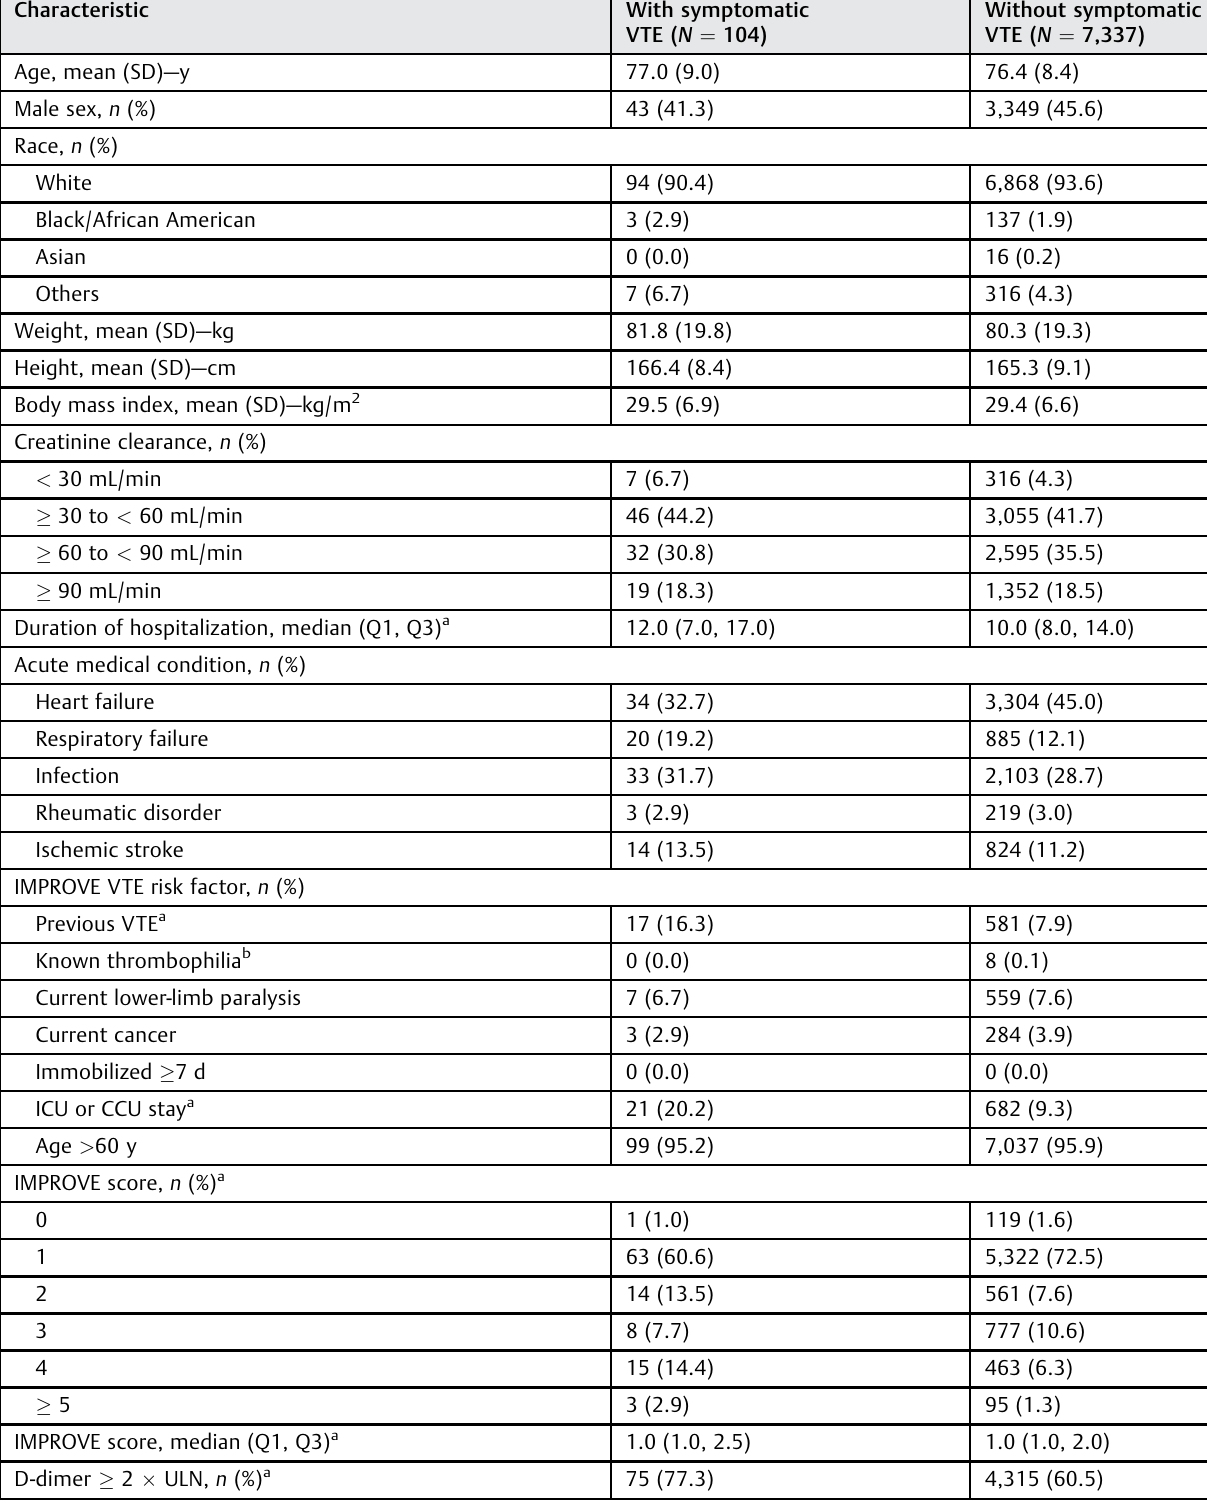
Table 1 Patient characteristics in the study population with and without symptomatic VTE